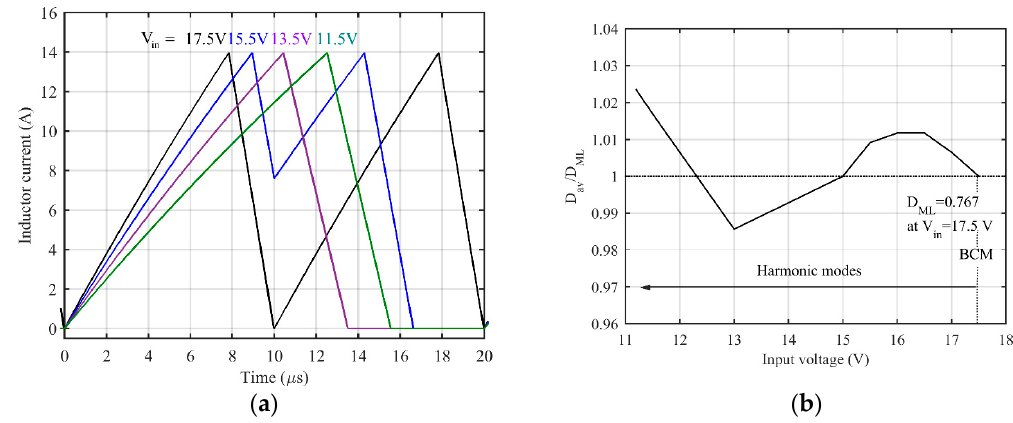
Figure 3. The behavior of ( a ) the inductor current and ( b ) the average duty ratio in the mode limit (boundary conduction mode (BCM)) and in harmonic operation modes.